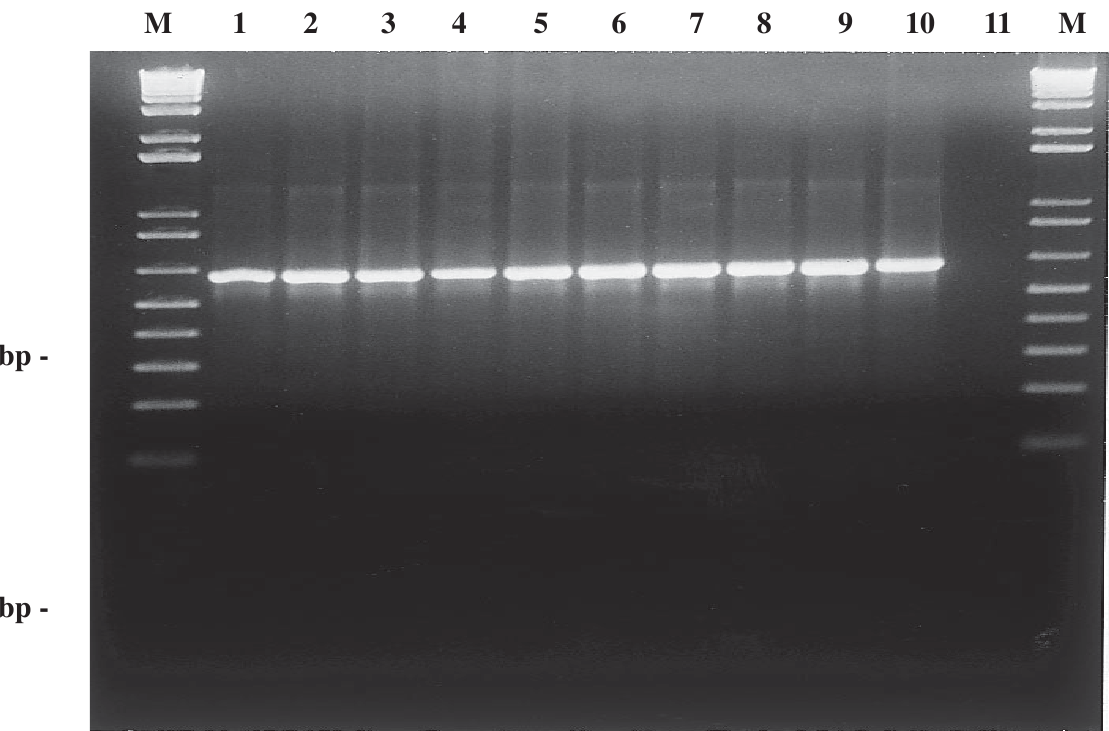
Fig. 1. Agarose gel with PCR amplification products of ITS1-5.8S-ITS2 region of rDNA of Phaeoacremonium spp., using ITS4 and ITS5 as primers. Lanes 1-2, P. aleophilum CBS 246.91 and 157; lanes 3-5, P. chlamydosporum CBS 161.90, CBS 239.74 and 56; lanes 6-7, P. angustius CBS 249.95 and CBS 777.83; lanes 8-9, P. inflatipes CBS 391.71 and CBS 222.95; lane 10, P. rubrigenum CBS 498.94; lane 11, negative control of sterile distilled water; lane M, 1Kb Plus DNA Ladder (Gibco-BRL, Life Technologies). A fragment of about 620 bp is observed with all the